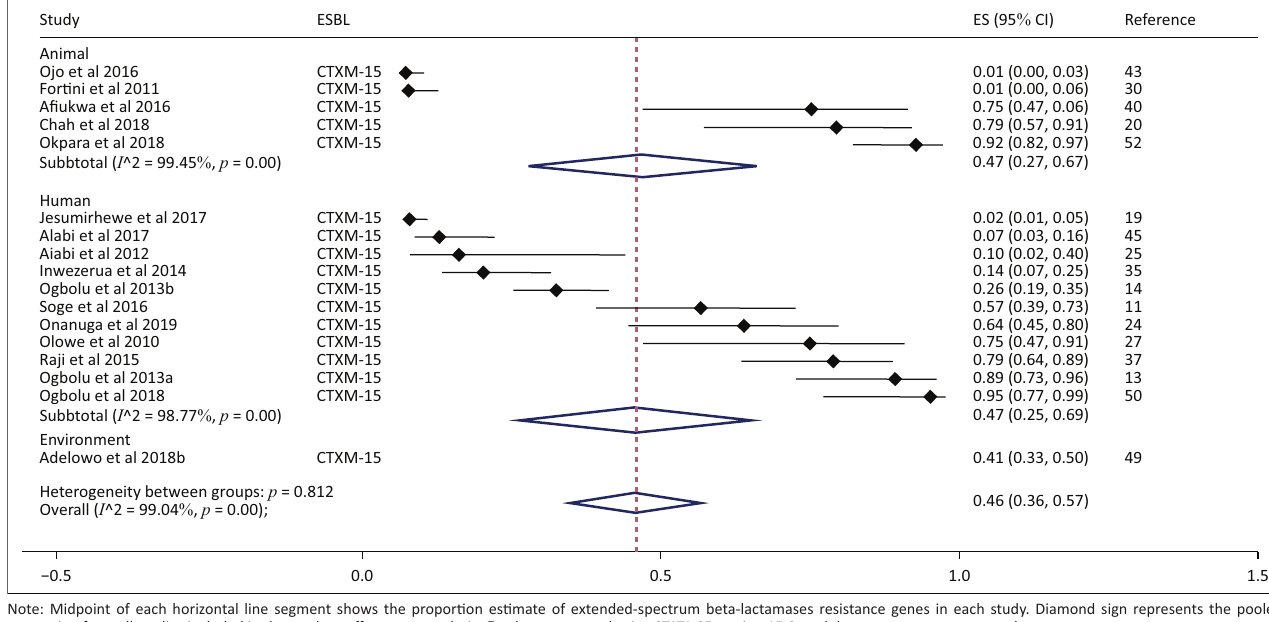
Note: Midpoint of each horizontal line segment shows the proportion estimate of extended-spectrum beta-lactamases resistance genes in each study. Diamond sign represents the pooled proportion from all studies included in the random-effect meta-analysis. P -values generated using STATA SE version 15.0 and does not represent exact values. CI, confidence interval; ESBL, extended-spectrum beta-lactamases. extended-spectrum beta-lactamase in Nigeria (1990–2019). FIGURE 3: Subgroup analysis and forest plot of proportion estimates of bla CTX-M-15